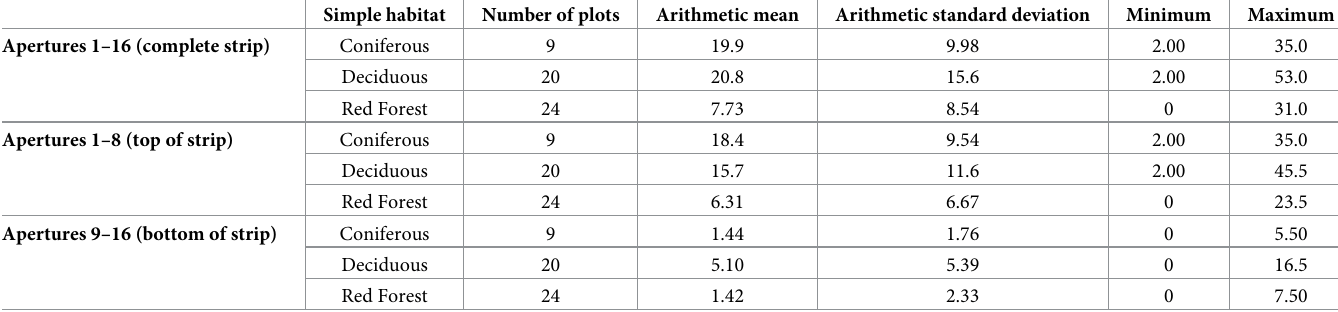
Table 3. Feeding activity summarised by simple